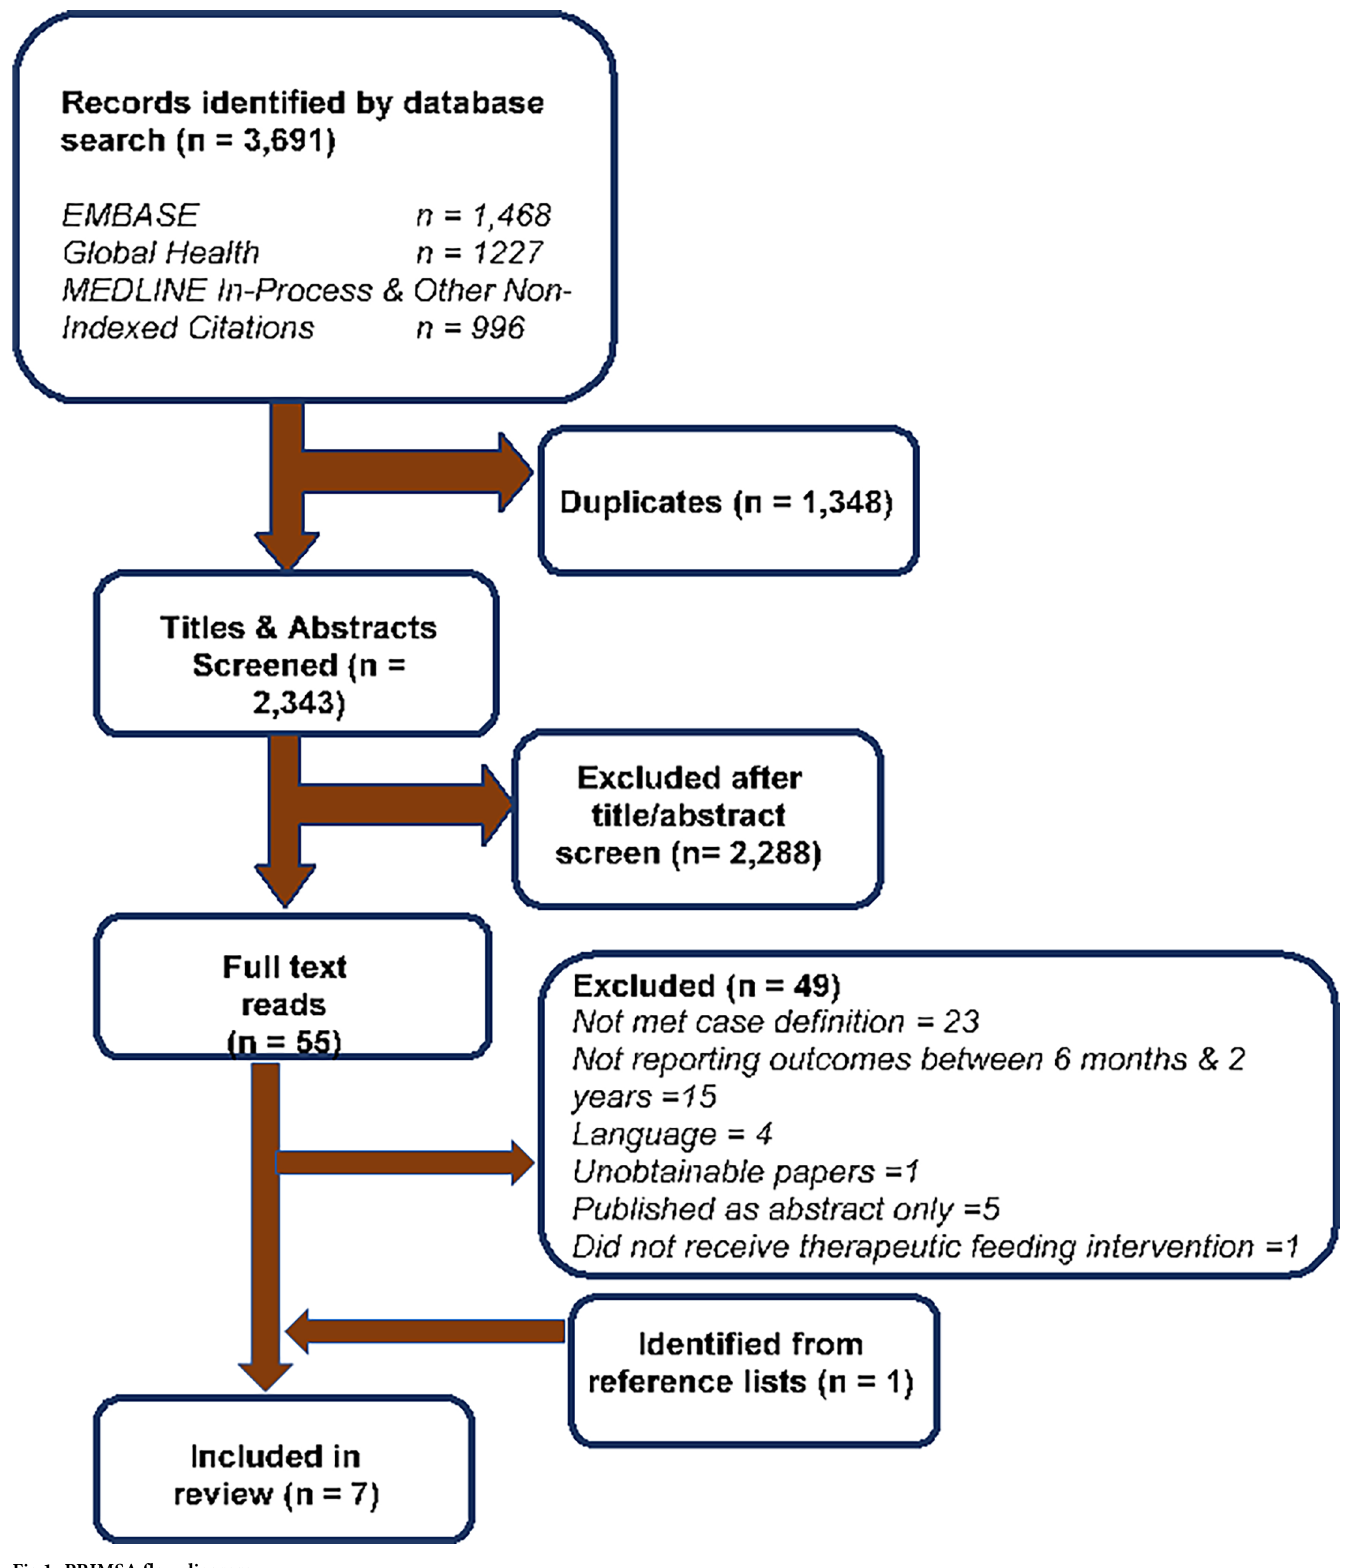
Fig 1. PRIMSA flow diagram.